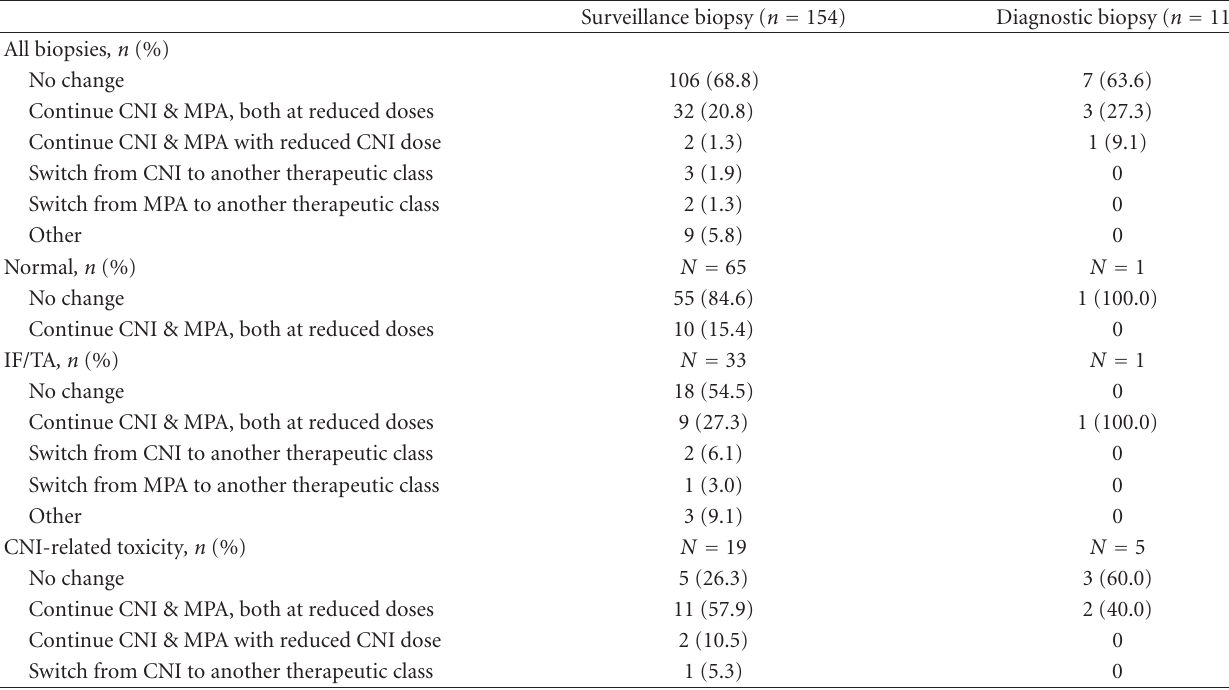
Table 2: Modification of immunosuppression following biopsy and local diagnosis of normal, IF/TA or immunosuppression-related toxicity. All di ff erences were